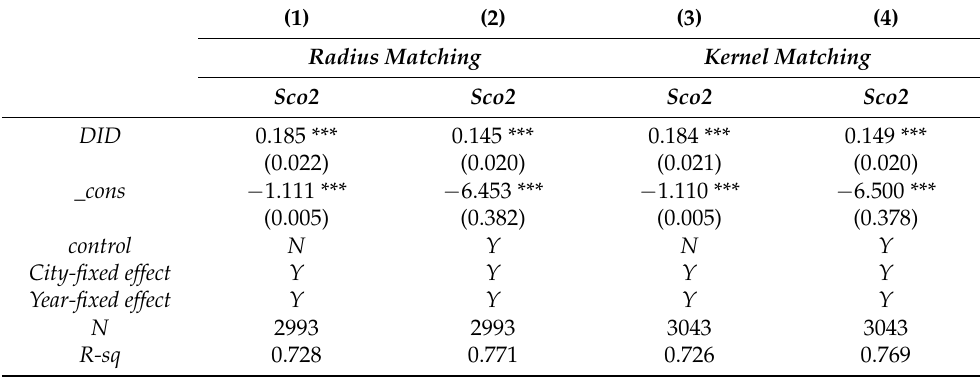
Table 4. PSM-DID.